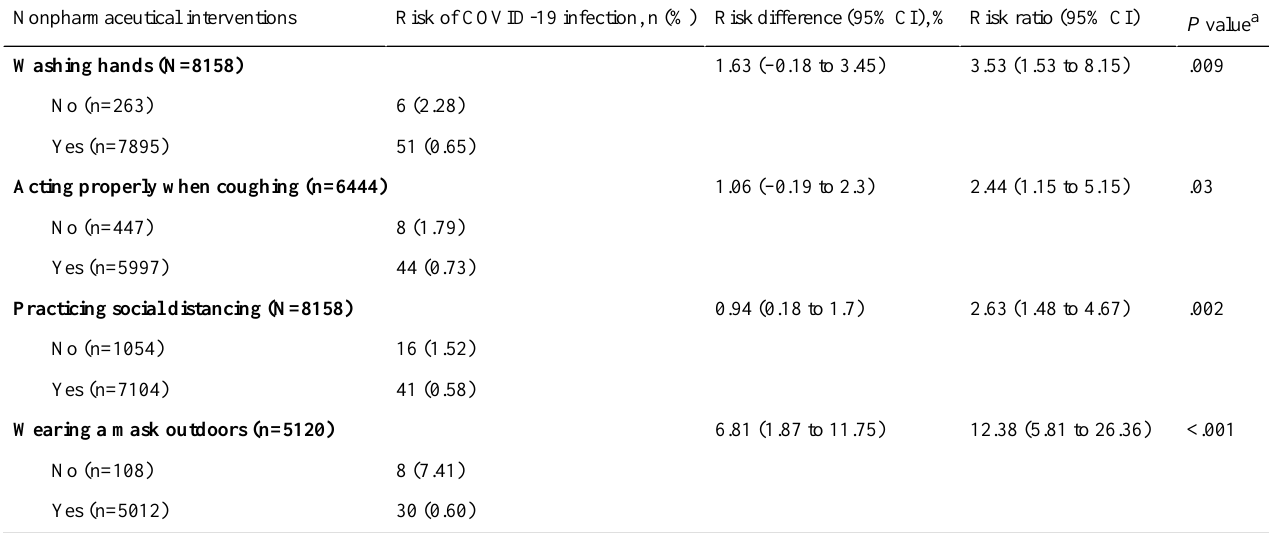
Table 5. The association between COVID-19 infection and four nonpharmaceutical